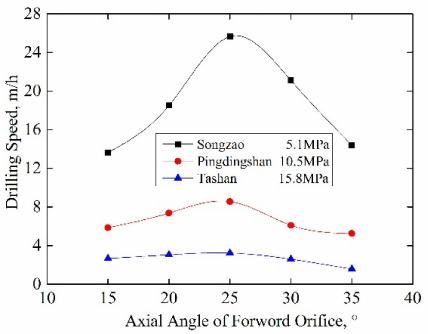
Figure 7. Graph showing the relationship between self-drilling speed and forward orifice axial angle. Strength of coal samples: 5.1, 10.5 and 15.8 MPa.